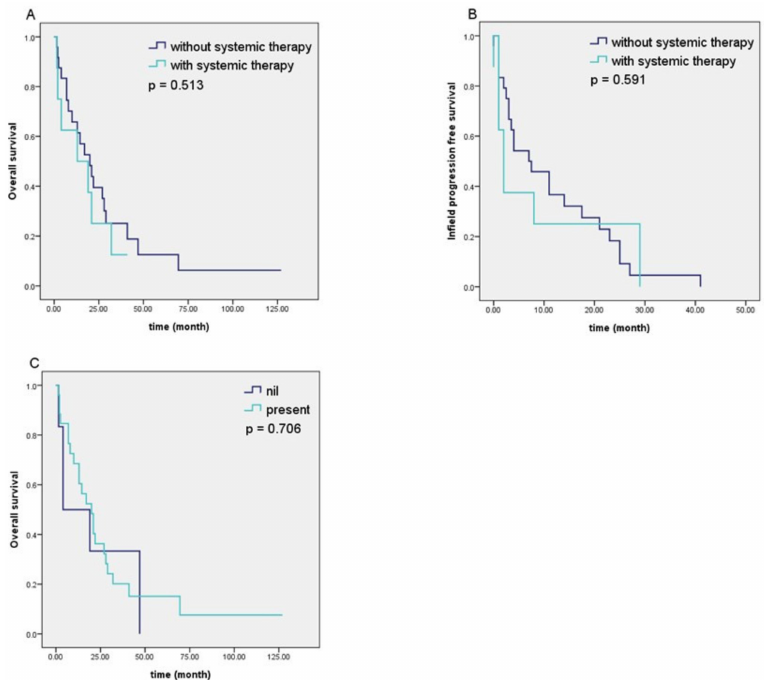
Figure 4. ( A ) Overall survival and ( B ) infield progression-free survival for using systemic therapy subgroup and not-using systemic therapy subgroup; ( C ) overall survival for the subgroup with and without outfield recurrence and/or distant